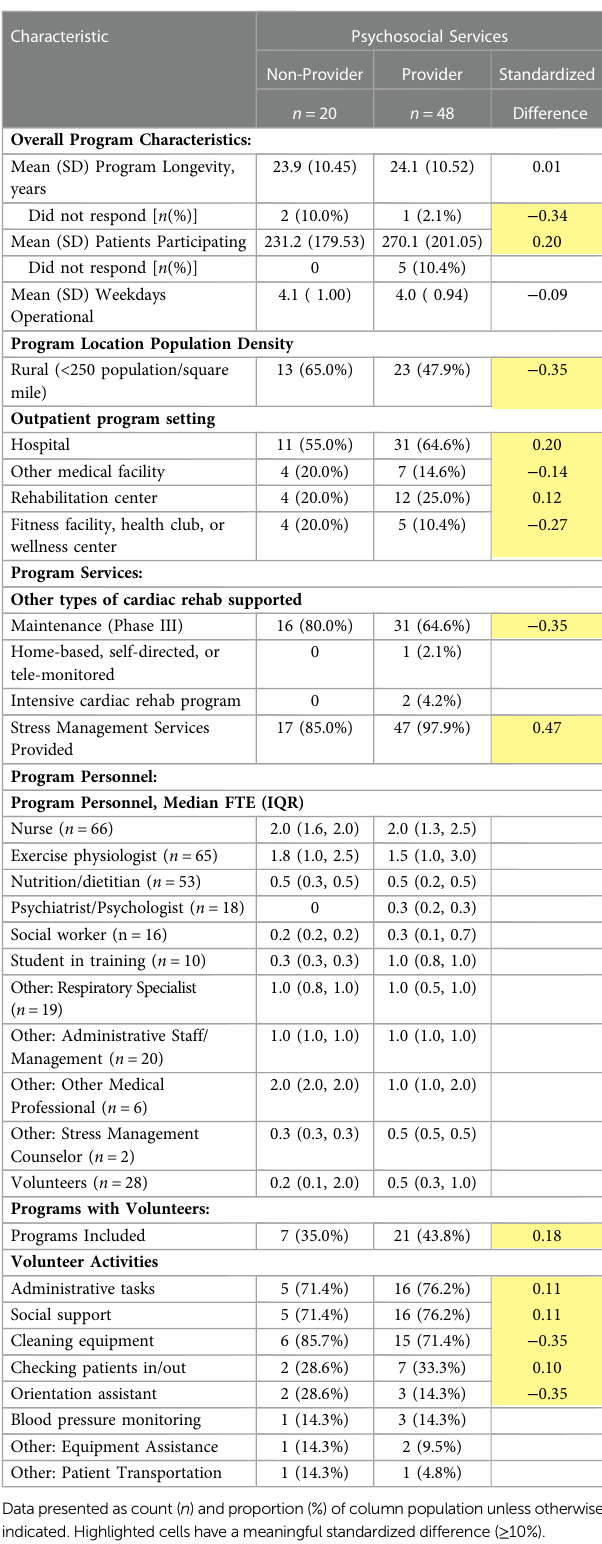
TABLE 1 Characteristics of licensed certi fi ed outpatient cardiac rehabilitation